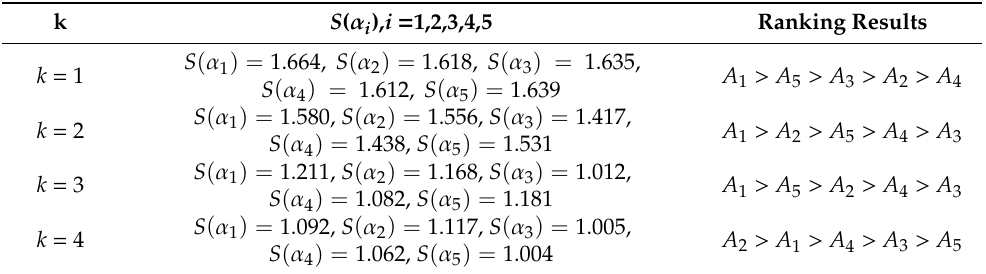
Table 6. Ranking results by using the di ff erent parameter k in the q -RPFDWHM